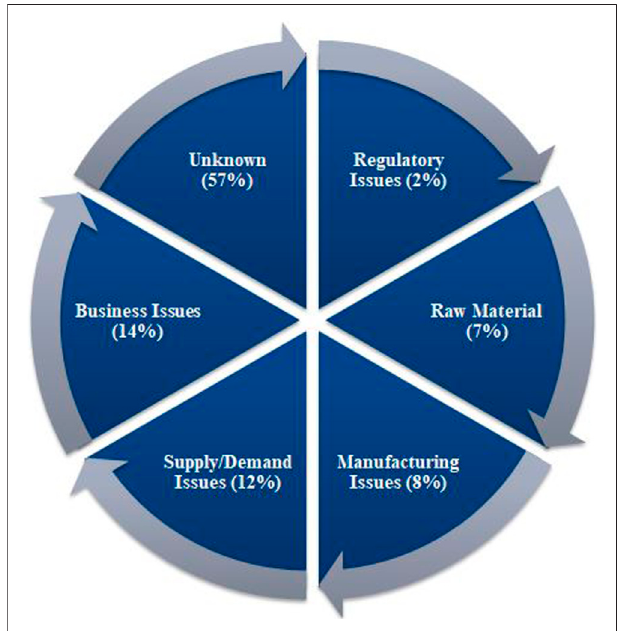
Frontiers in Pharmacology |